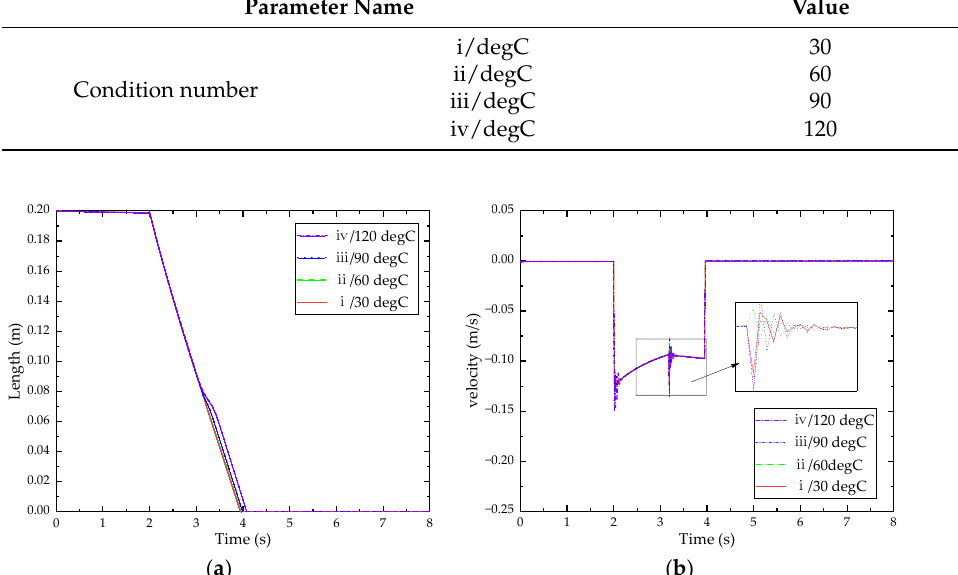
Table 6. Oil temperature under different working conditions.